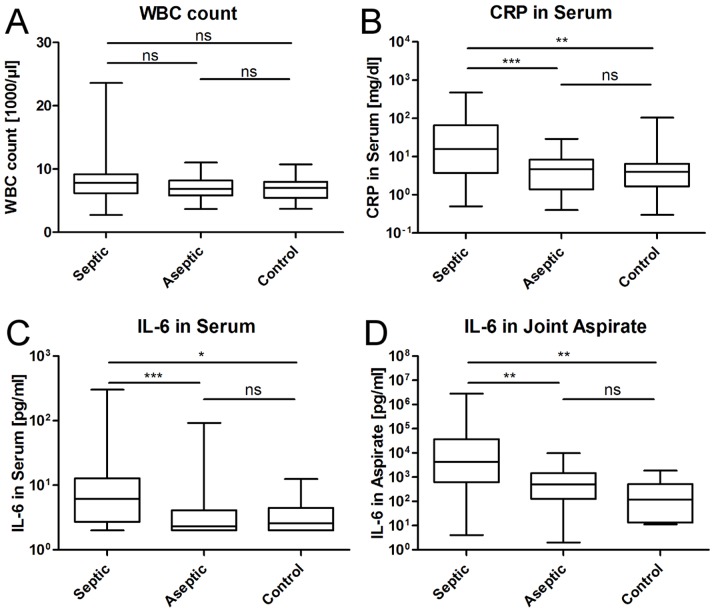
Differences in means between groups.Shown is the boxplot of the mean, 25%- and 75%-quartile and range of the values measured, as well as statistical differences between groups. Except for white blood cell count (A), all other parameters measured (B: CRP in Serum, C: IL-6 in Serum, D: IL-6 in joint aspirate) showed significant differences between the PJI group and the aseptic groups.